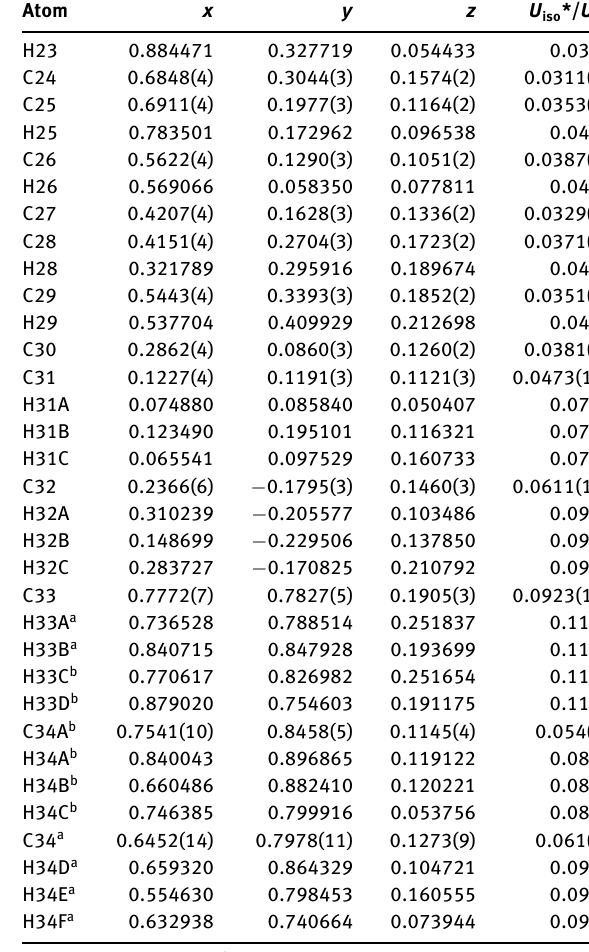
Table 2: Fractional atomic coordinates and isotropic or equivalent isotropic displacement parameters (Å 2